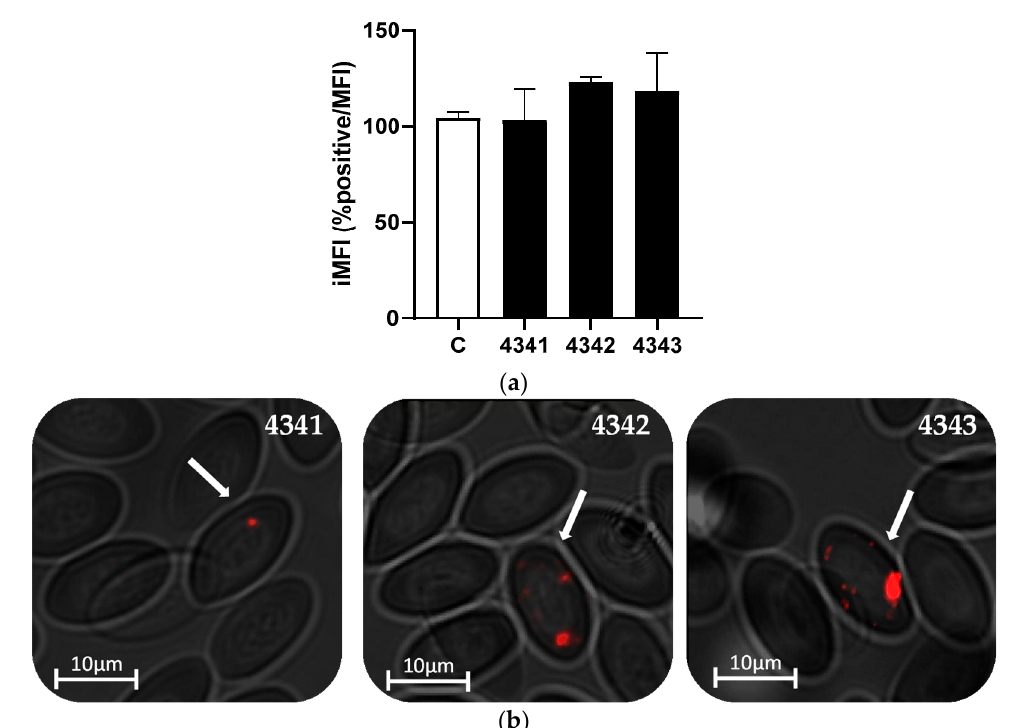
Figure 4. Peptide binding to rainbow trout RBCs in vivo, by means of flow cytometry. ( a ) Integrated median fluorescence intensity (iMFI) (% positive cells × MFI) of RBCs from blood of rainbow trout injected intravenously with the three selected peptides, 3 hpi with 100 µ M of each peptide, analyzed by flow cytometry. Data represent the mean ± standard deviation (SD), n = 3. Kruskal–Wallis test with Dunn’s multiple comparison test was performed ( p < 0.05). C means control RBCs. ( b ) Representative images of RBCs from blood of rainbow trout injected intravenously with the three selected peptides, 3 hpi with 100 µ M of each peptide. The images were taken with the IN Cell Analyzer 6000 Cell Imaging system at 40 × magnification. Peptides are labeled with Rhd (red). White arrows indicate peptide binding to RBCs.